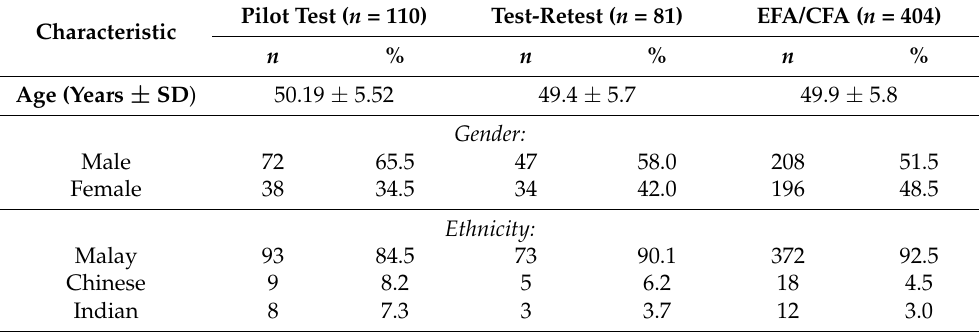
Table 1. Characteristics of the participants for the AAAQ